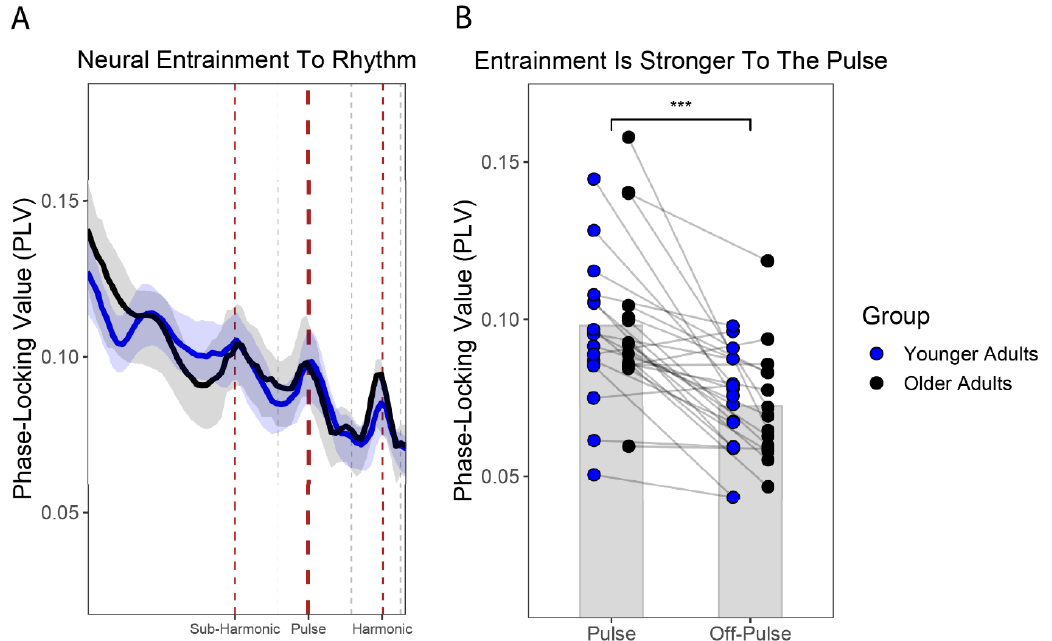
Figure 3. Neural entrainment to musical pulse and rhythm. ( A ) Phase-locking values (PLVs) grand- averaged across all EEG channels and each participant’s self-selected musical recordings, following pulse normalization of the PLVs. Both younger adults (blue) and older adults (black) exhibited stronger PLVs at rhythm-related levels (e.g., sub-harmonic, pulse, and harmonic levels, respectively; red dashed lines), manifested as local maxima in the PLV plots, compared to off-rhythm levels (e.g., off-sub-harmonic, off-pulse, off-harmonic, respectively; grey dashed lines), manifested as local minima. Shaded errors bars are bootstrapped 95% confidence intervals. ( B ) Grand-averaged PLVs at the pulse and off-pulse levels for each younger adult (blue) and each older adult (black). The PLVs were consistently stronger at the pulse level than at the off-pulse level (*** p ≤ 0.001). Grey bars represent the mean PLV for the pulse and off-pulse level, collapsing across younger and older adults (i.e., a main effect of rhythm-level of pulse vs. off-pulse).